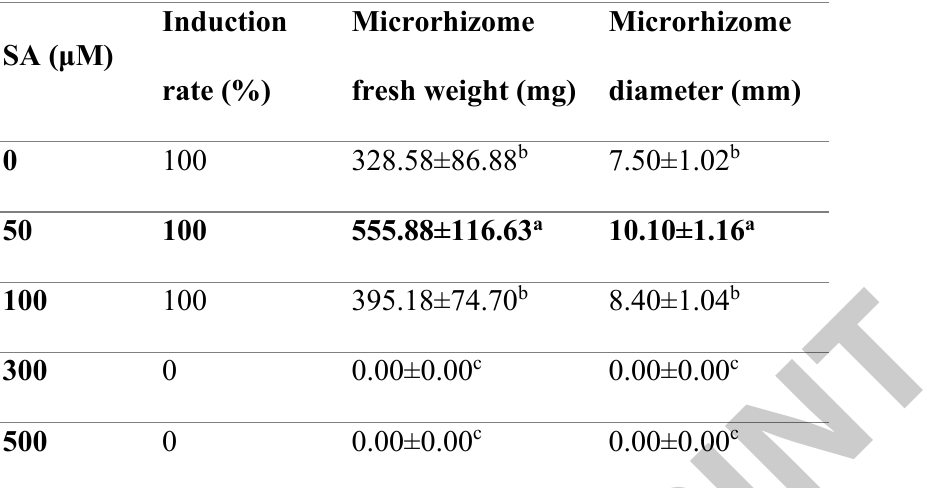
Table 8. Impact of different YE concentrations on microrhizome induction and growth YE (mg/L)